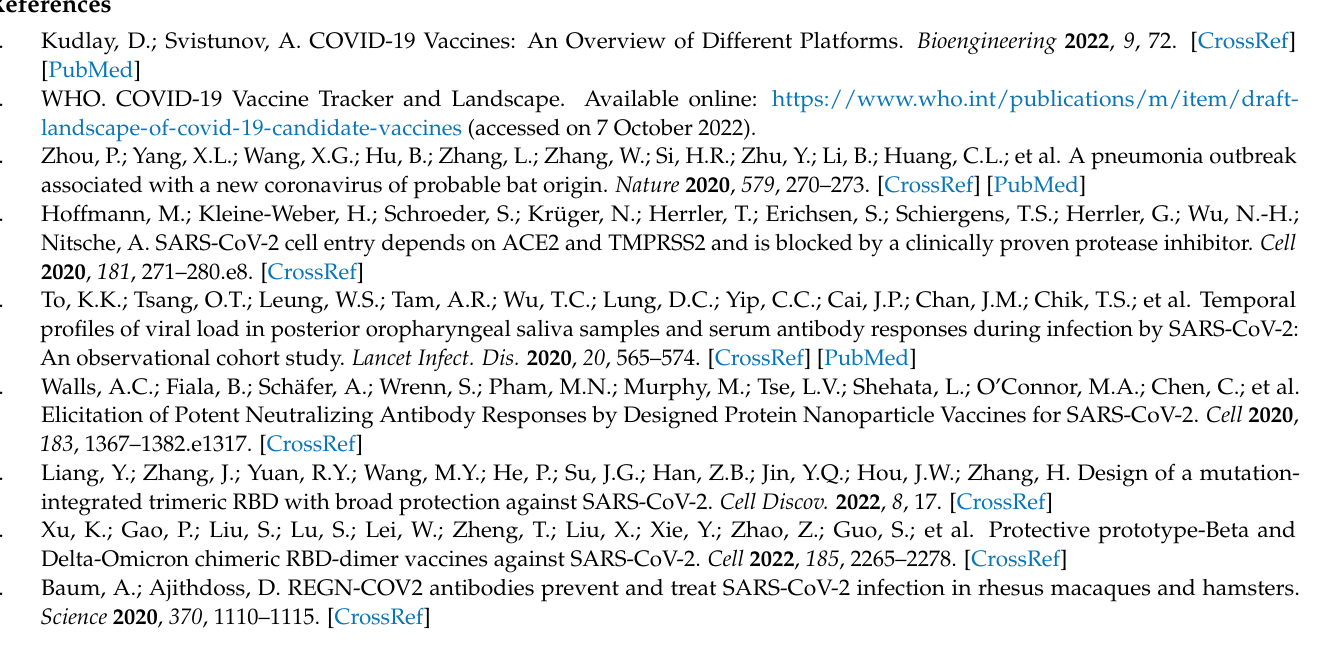
Figure S1: SCTV01A enhances RBD-specific antibody titer and NAT 50 titer in C57BL/6 mice; Figure S2: Relative change of body weight and body temperature in Rhesus Macaques at different time points after SCTV01A immunization; Figure S3: SARS-CoV-2 viral load of different tissues was determined using RT-qPCR at 7 dpi; Figure S4: Chest X-ray images in rhesus macaques at different time points after SARS-CoV-2 infection; Figure S5: Body weight and immunogenicity were monitored to evaluate the safety of SCTV01A in nonhuman